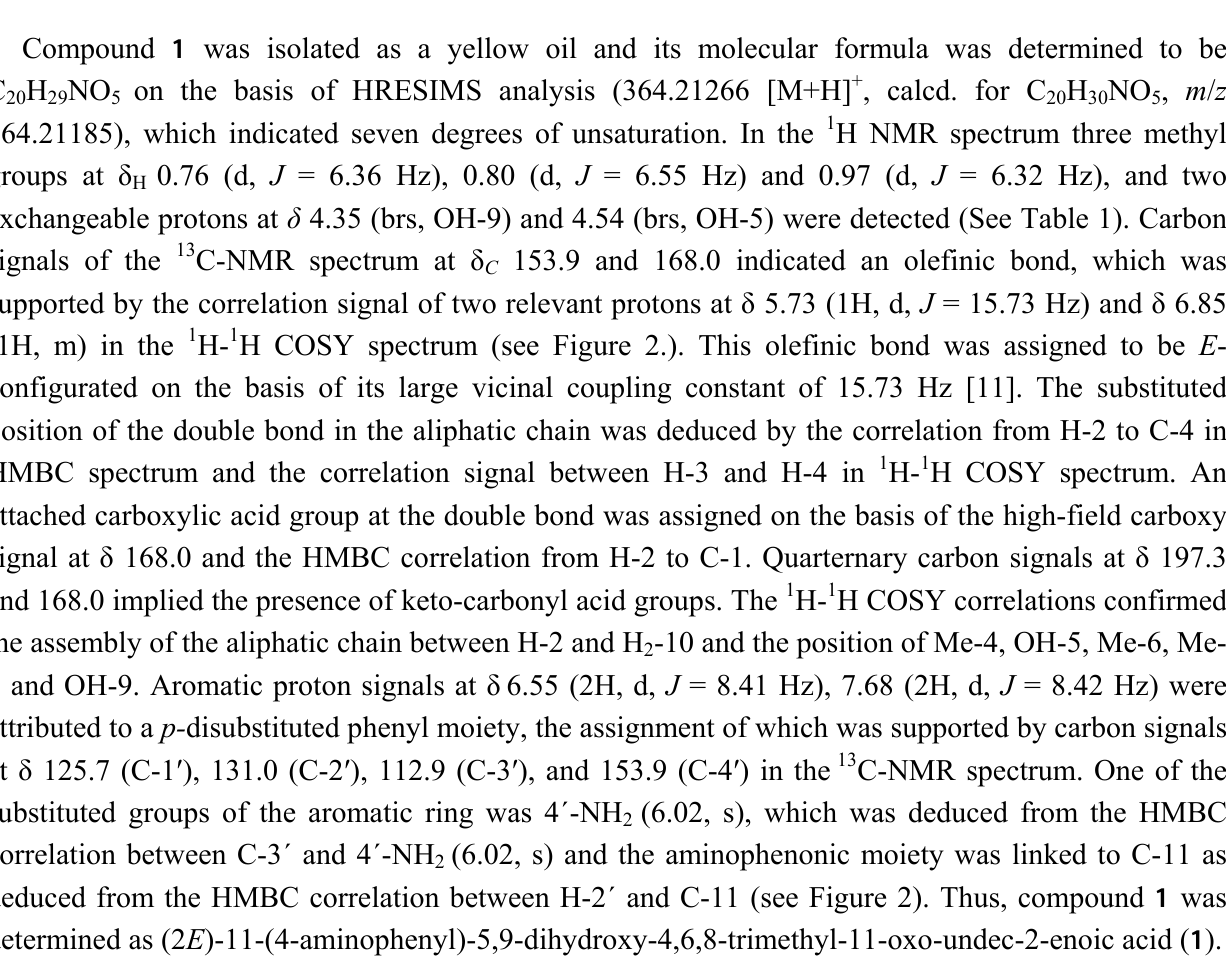
Figure 2. Key COSY and HMBC correlations of compound 1